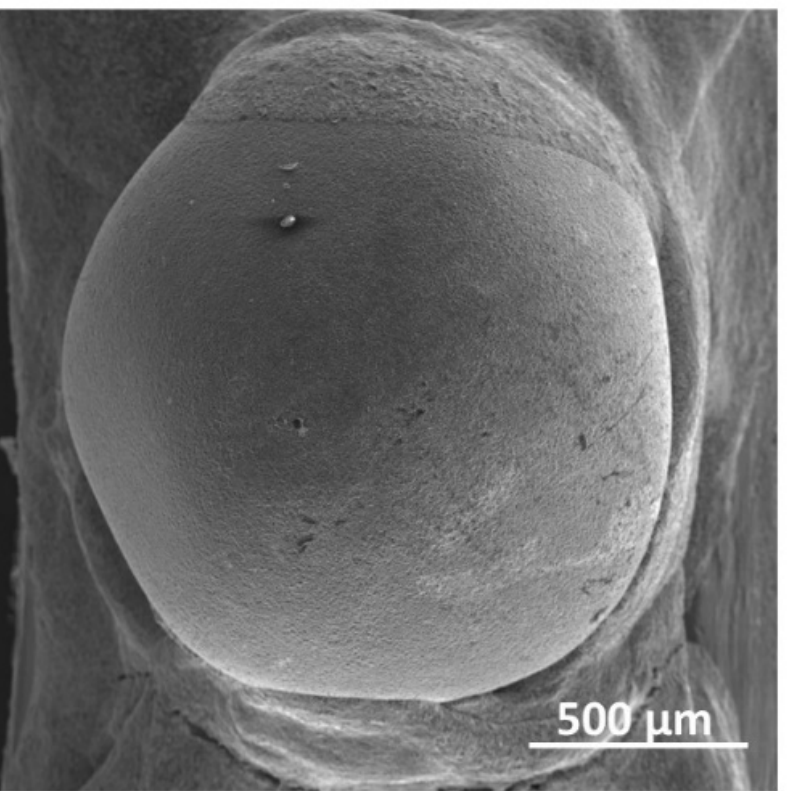
Figure 5. SEM image of the non-polished p-TRISO particle Figure - 5. SEM image of the non-polished p-TRISO particle sphere.